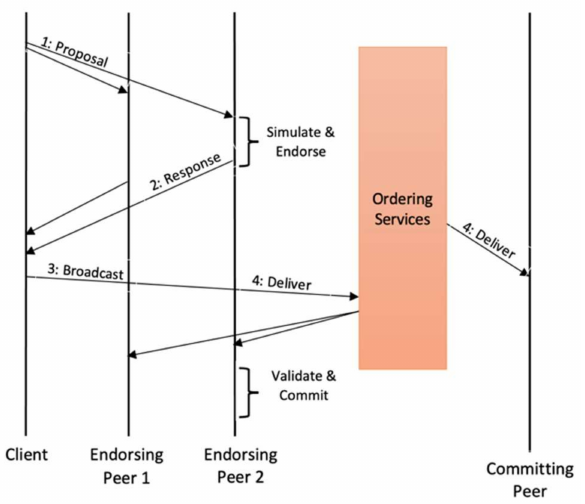
Figure 2. Transaction flow of ordering service. Source: